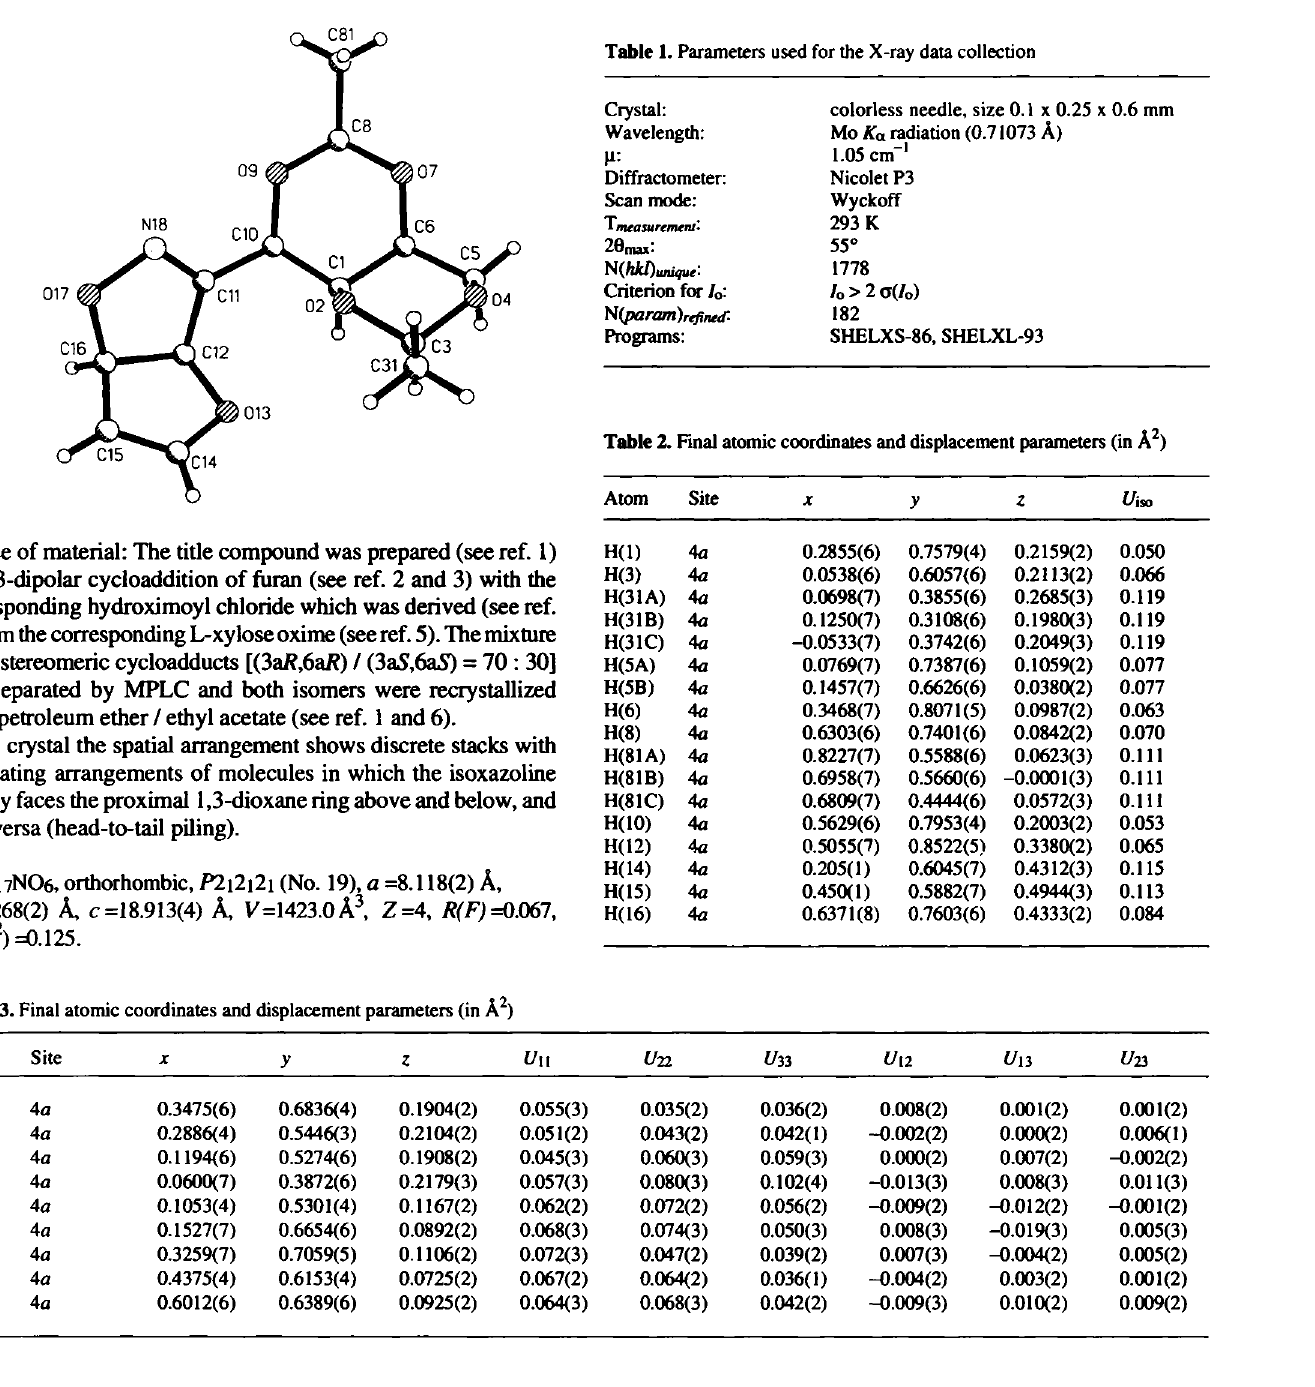
Table 2. Final atomic coordbates and displacement parameters (in A^)